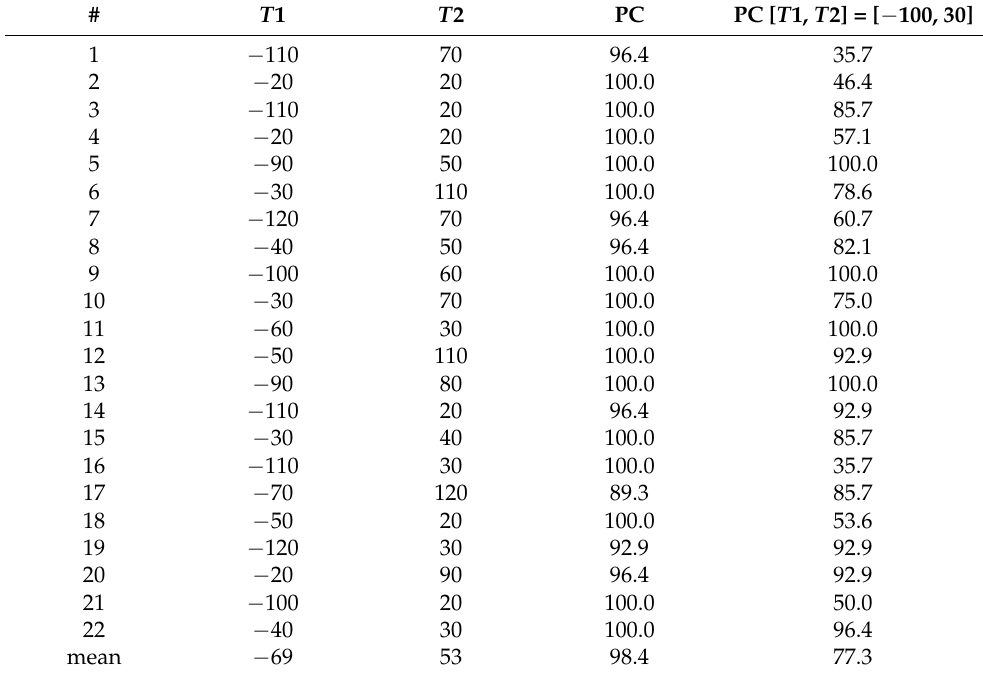
Table 3. Optimal time frame and maximum PC value of each event for the BCP algorithm and PC values for best overall time